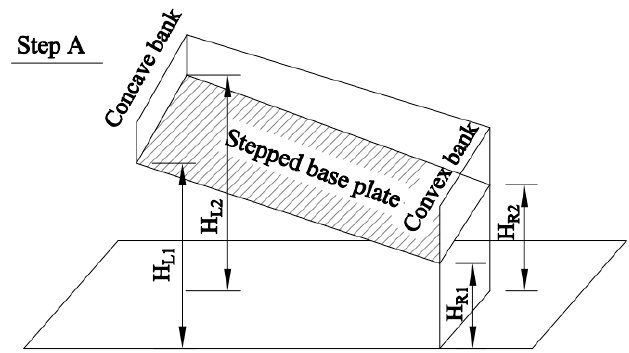
Table 1. The conditions of the prototype and physical experimental model.